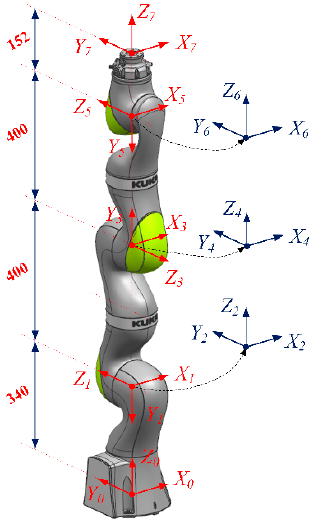
Figure 3. The link coordinate frames of the manipulator. Table 1. DH (Denavit & Hartenbrtg) parameters of the manipulator.